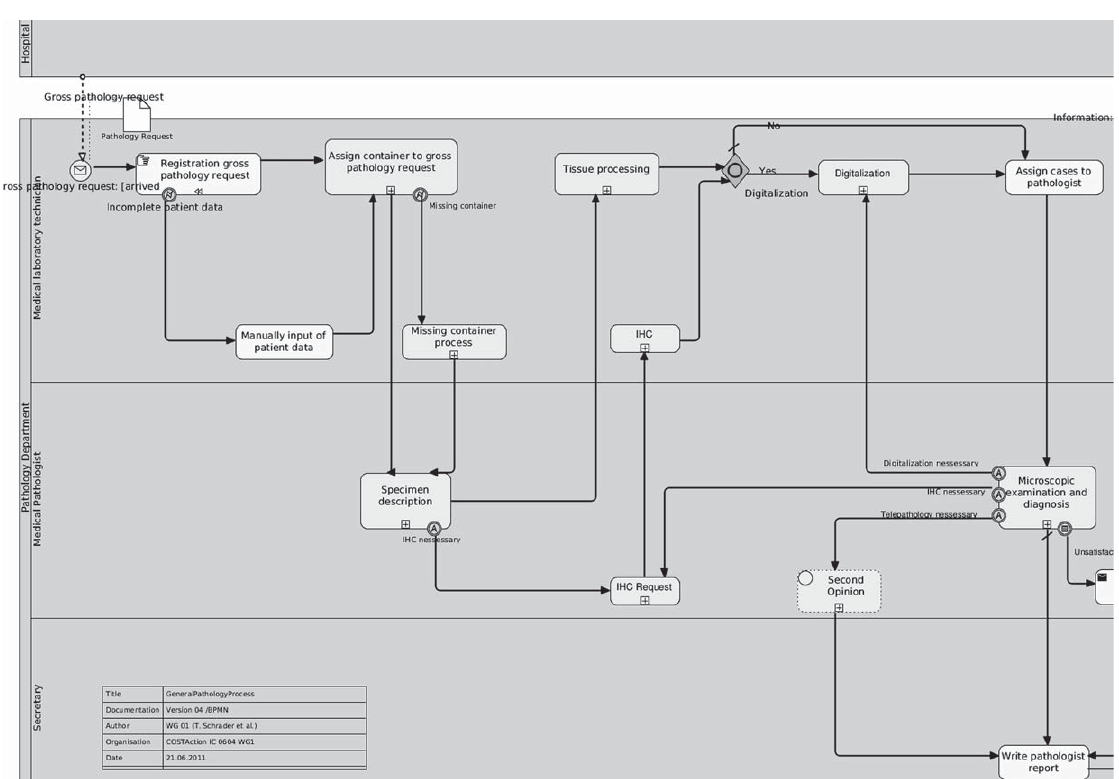
Fig. 3. BMN in pathology workflow, starting in specimen